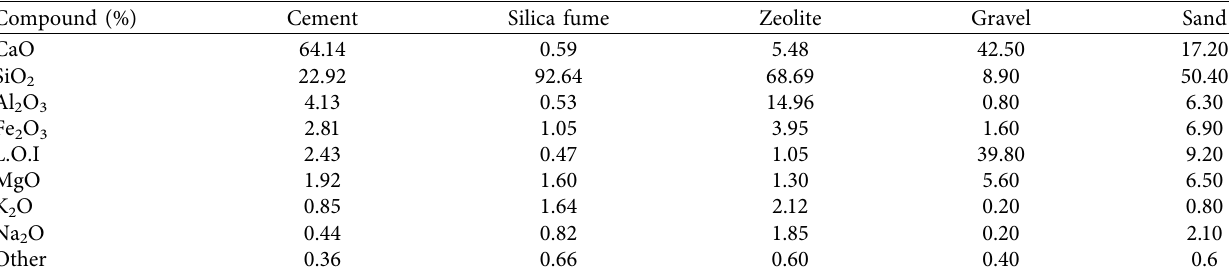
Table 2: Composition of cementitious materials and aggregates.